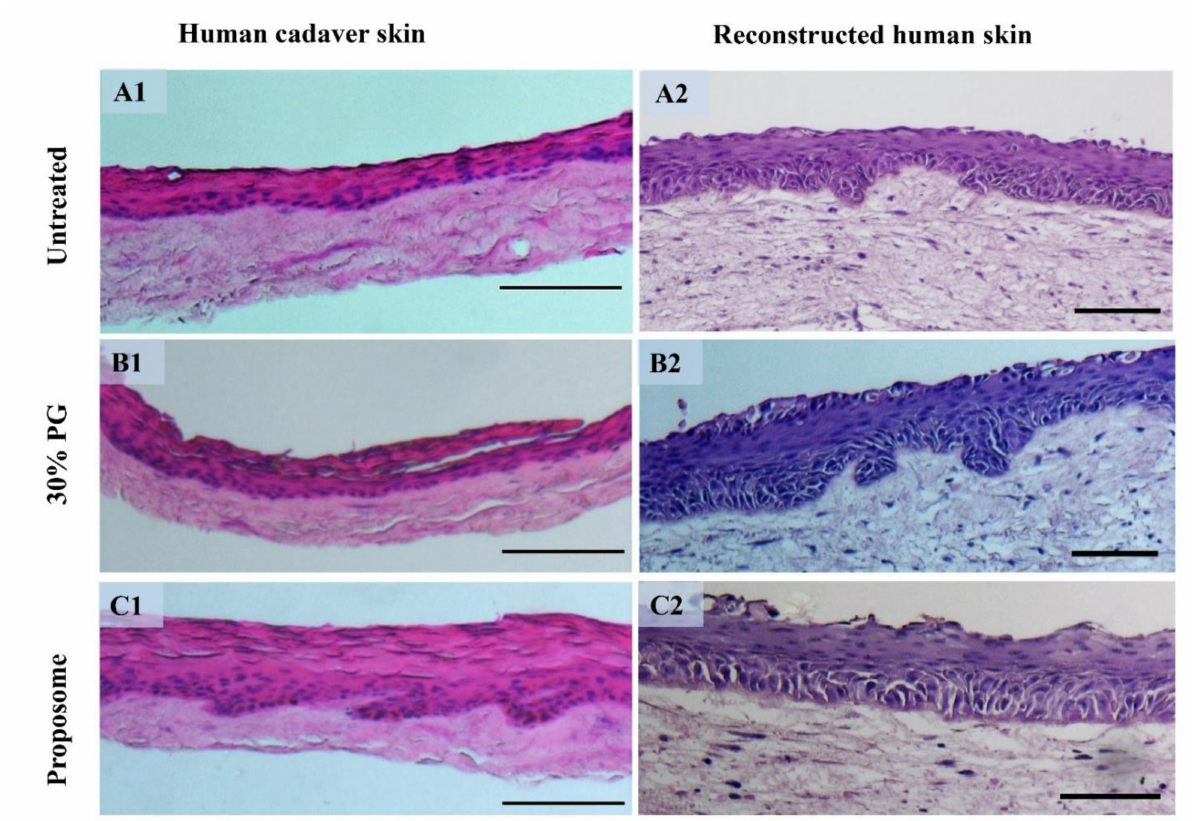
Figure 7. Histological section after hematoxylin and eosin (H&E) staining of human cadaver skin and RHS before and after treatment. ( A1 ) Untreated human cadaver skin and ( A2 ) RHS. ( B1 ) Human cadaver skin and ( B2 ) RHS treated with 30% PG. ( C1 ) Human cadaver skin and ( C2 ) RHS treated with blank proposome. (Scale bar = 100 µ